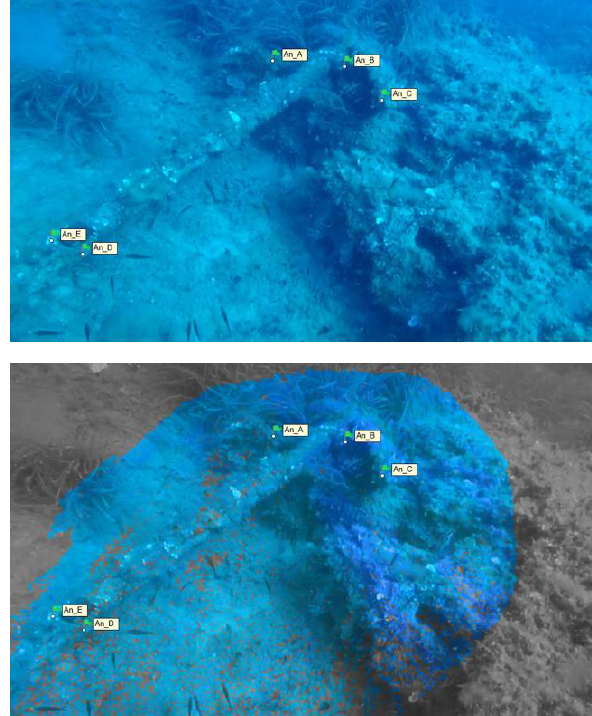
Figure 5. Images of the preliminary model of anchors off Marzamemi.